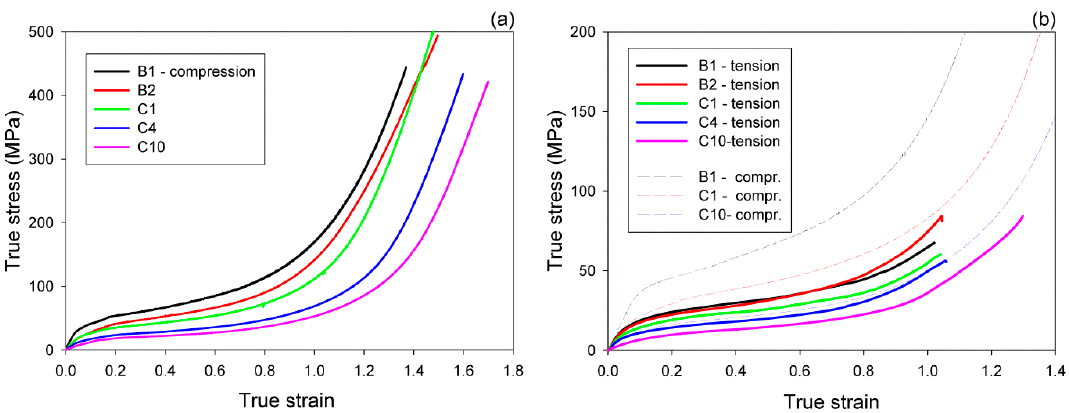
Figure 1. Representative true stress–true strain curves determined for samples of iPB-1 homo- and copolymers deformed at room temperature: in the plane-strain compression ( a ); and in tension ( b ). In ( b ), the compression curves are added for comparison and plotted with thin dashed lines.